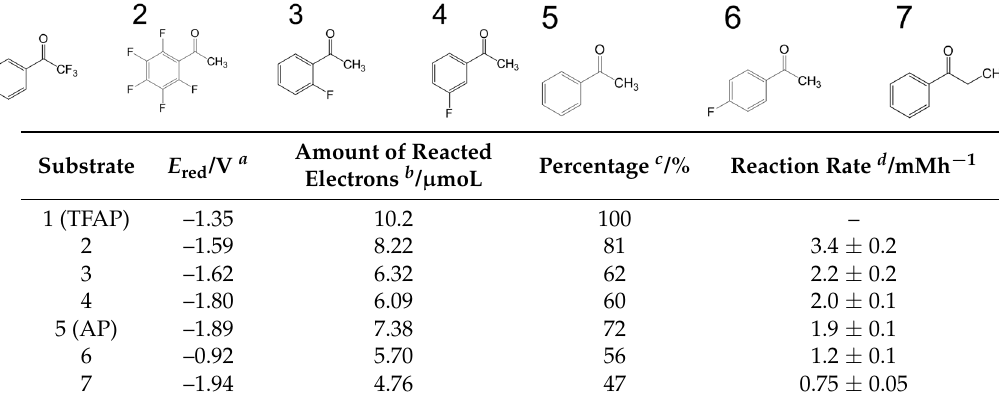
Substrate E red /V a 1 (TFAP) –1.35